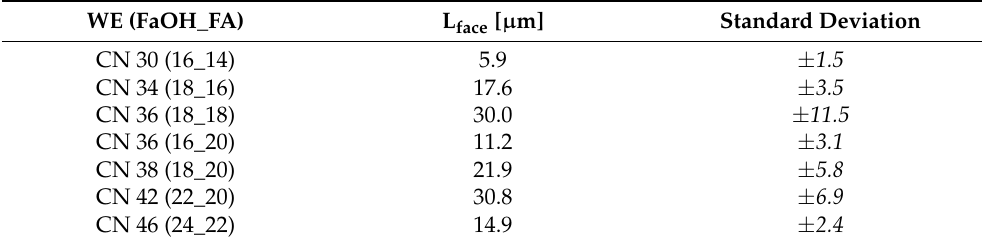
Table 2. Face length (L face ) WE crystals in mono-ester gels (10% [ m / m ] of WE in MCT oil). L face : average of ten longest straight faces, respectively. Cooling rate: 5 K/min.